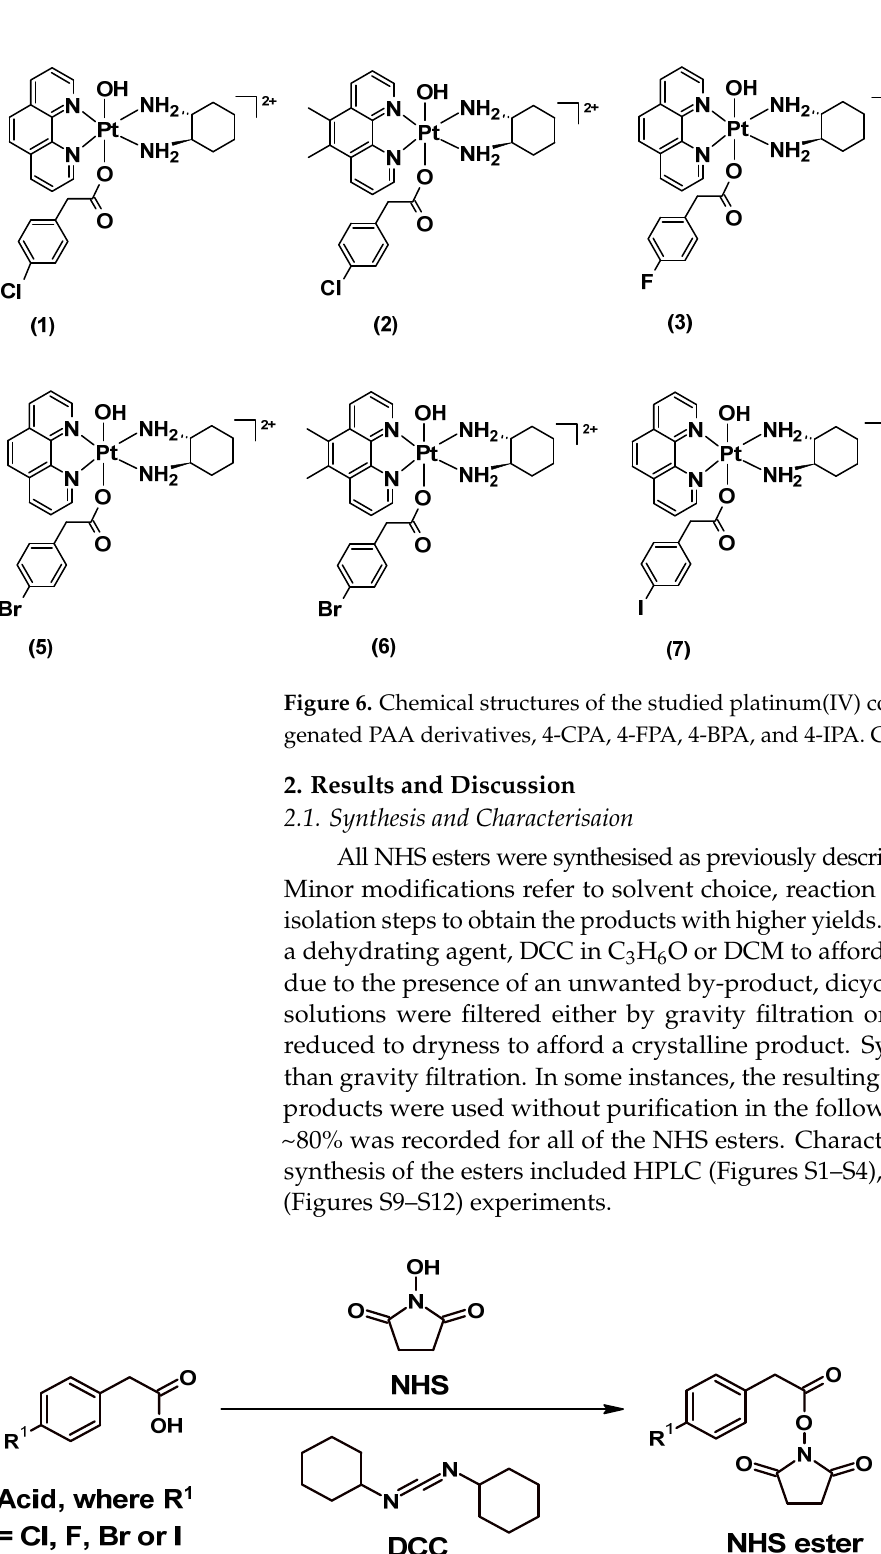
Figure 7. General synthetic pathway for NHS esters.